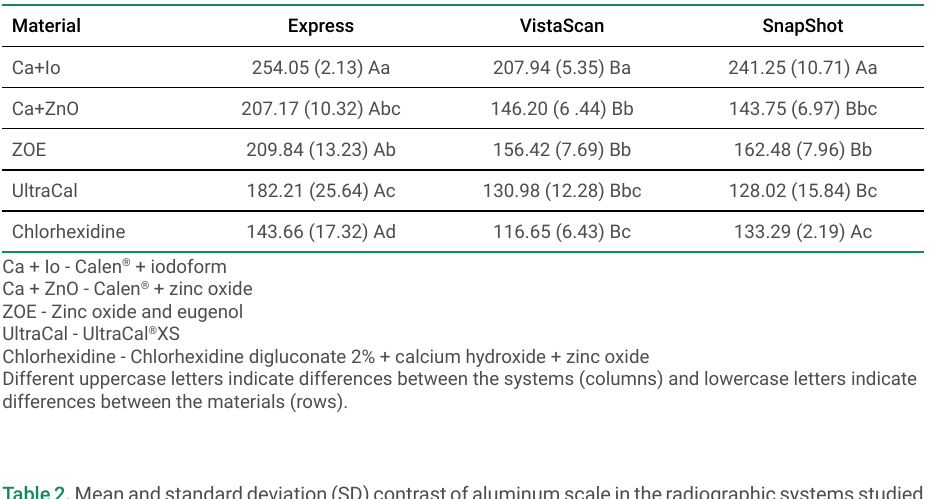
Table 2. Mean and standard deviation (SD) contrast of aluminum scale in the radiographic systems studied System Mean (SD) Express VistaScan